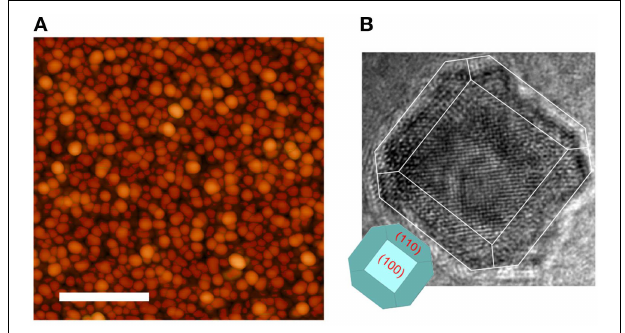
FIGURE 1 | (A) AFM micrograph of crowded nanoparticles, the scale bar represents 400 nm. (B) TEM image of a single 10 nm diameter particle and inset a model drawing of the appropriate Wulff reconstruction.